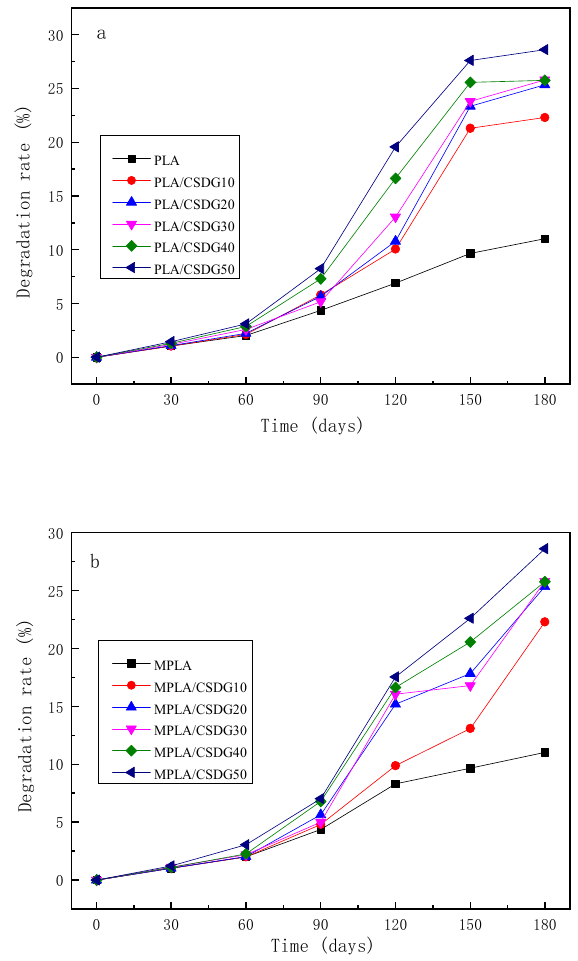
Figure 14. Degradability of ( a ) PLA/CSDG and ( b ) MPLA/CSDG composites.